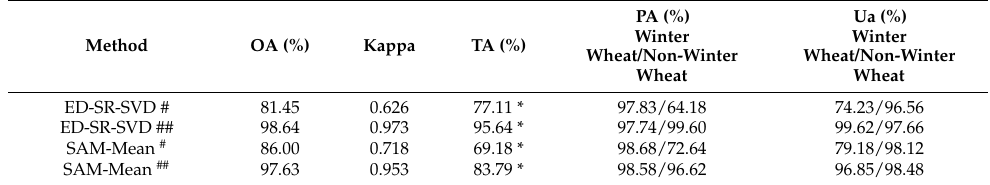
Figure 12. Winter wheat mapping results based on different methods. ‘#’ indicates prior knowledge is not used, while ‘##’ is the opposite. Table 6. Comparison of winter wheat mapping results with different